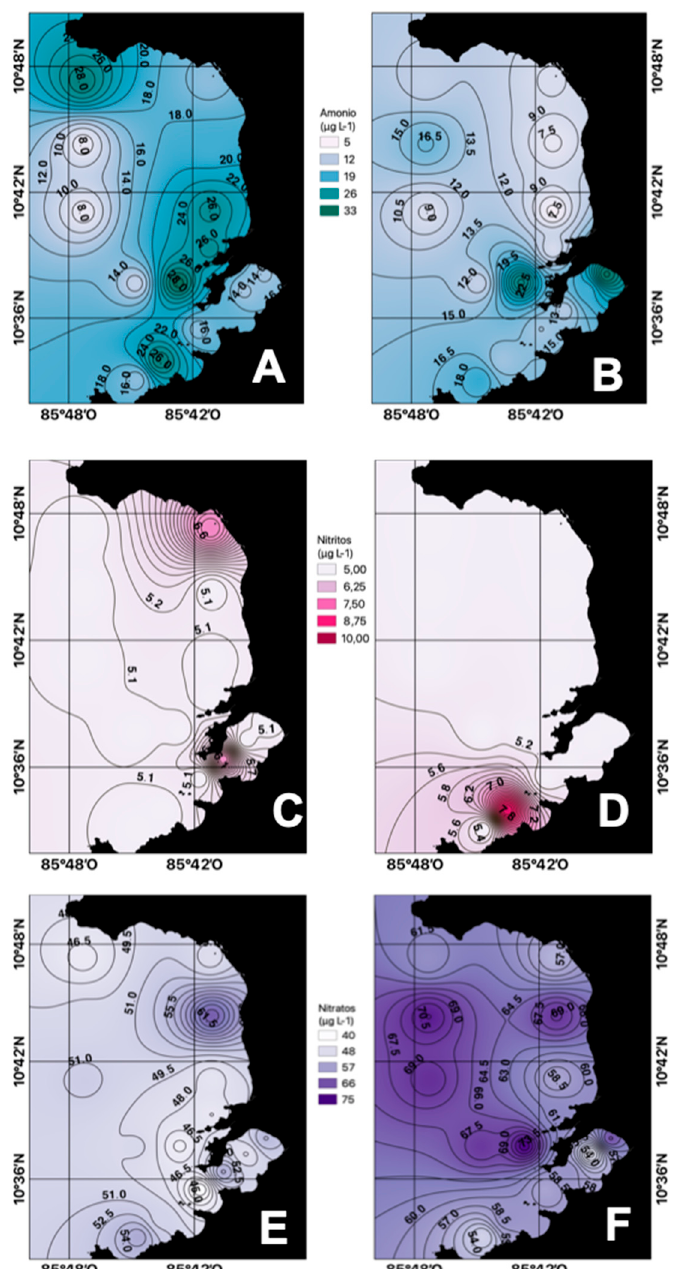
Figure 3. Spatial distribution of ammonia nitrogen (( A ) dry season, ( B ) rainy season), nitrites (( C ) dry season, ( D ) rainy season), and nitrates (( E ) dry season, ( F ) rainy season) in the Gulf of Papagayo.